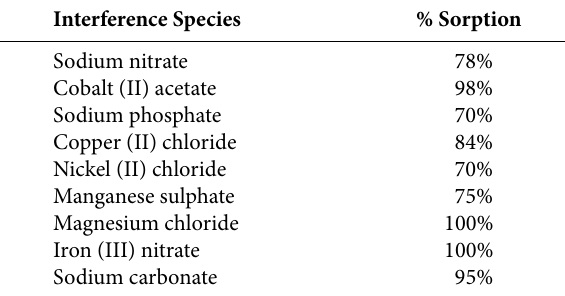
Table 5. Interference effect of electrolytes on the Cr(VI) removal Interference Species %